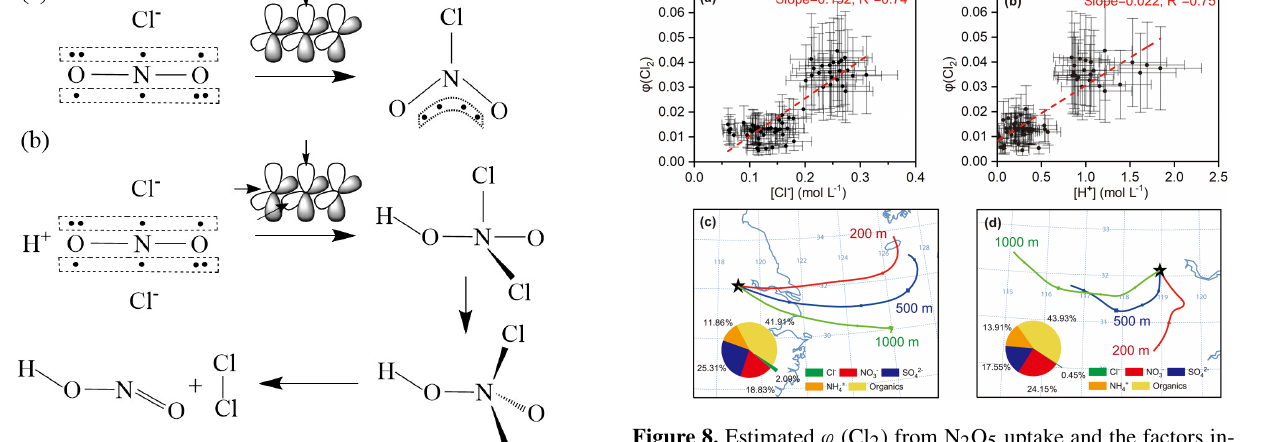
Figure 8. Estimated ϕ (Cl 2 ) from N 2 O 5 uptake and the factors in- fluencing ϕ (Cl 2 ) (a) and (b) dependencies of ϕ (Cl 2 ) on [Cl − ] and [H + ] in selected cases. (c) and (d) are examples of high ϕ (Cl 2 ) Figure 7. Proposed formation mechanisms of ClNO 2 and Cl 2 values in marine air masses (e.g., 13 April) and low ϕ (Cl 2 ) values from N 2 O 5 uptake. (a) Production of ClNO 2 from NO + and Cl − . 2 in inland air masses (e.g., 18 April) represented by 24h backward (b) Production of Cl 2 from NO + , Cl − , and H + . trajectories (see Fig. S2 for trajectories during the whole observa- 2 tions). Inserted pie charts show average aerosol chemical composi- tions during 21:40LT on 12 April to 00:40LT on 13 April and from 22:20 to 23:40LT on 17 April,